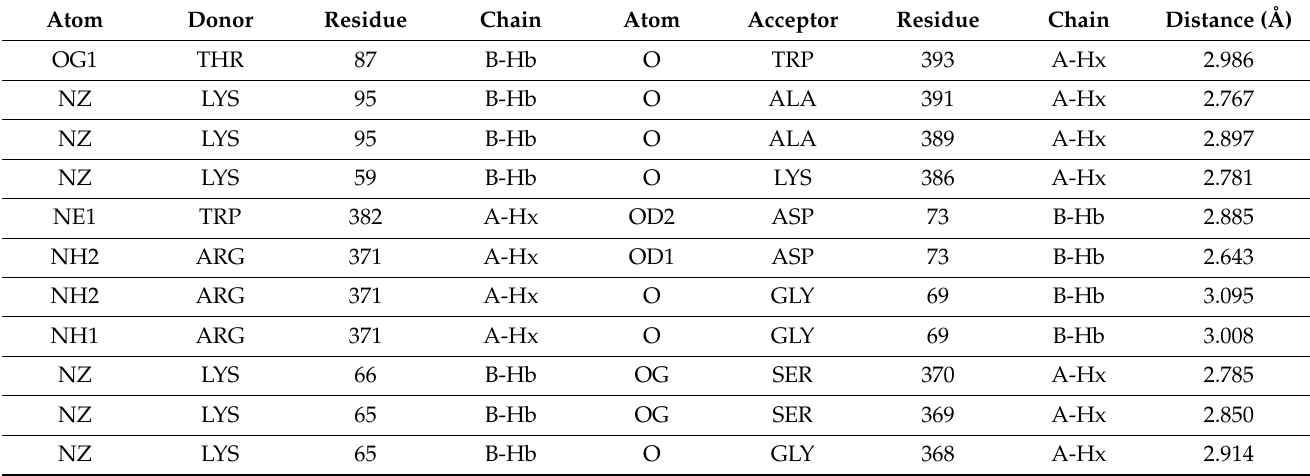
Table 2. Analysis of protein-protein interaction (hydrogen bond) at the hemopexin (Hx) and hemoglobin β -chain (Hb) interface. Hydrogen bond interactions were calculated using the Lig- plot